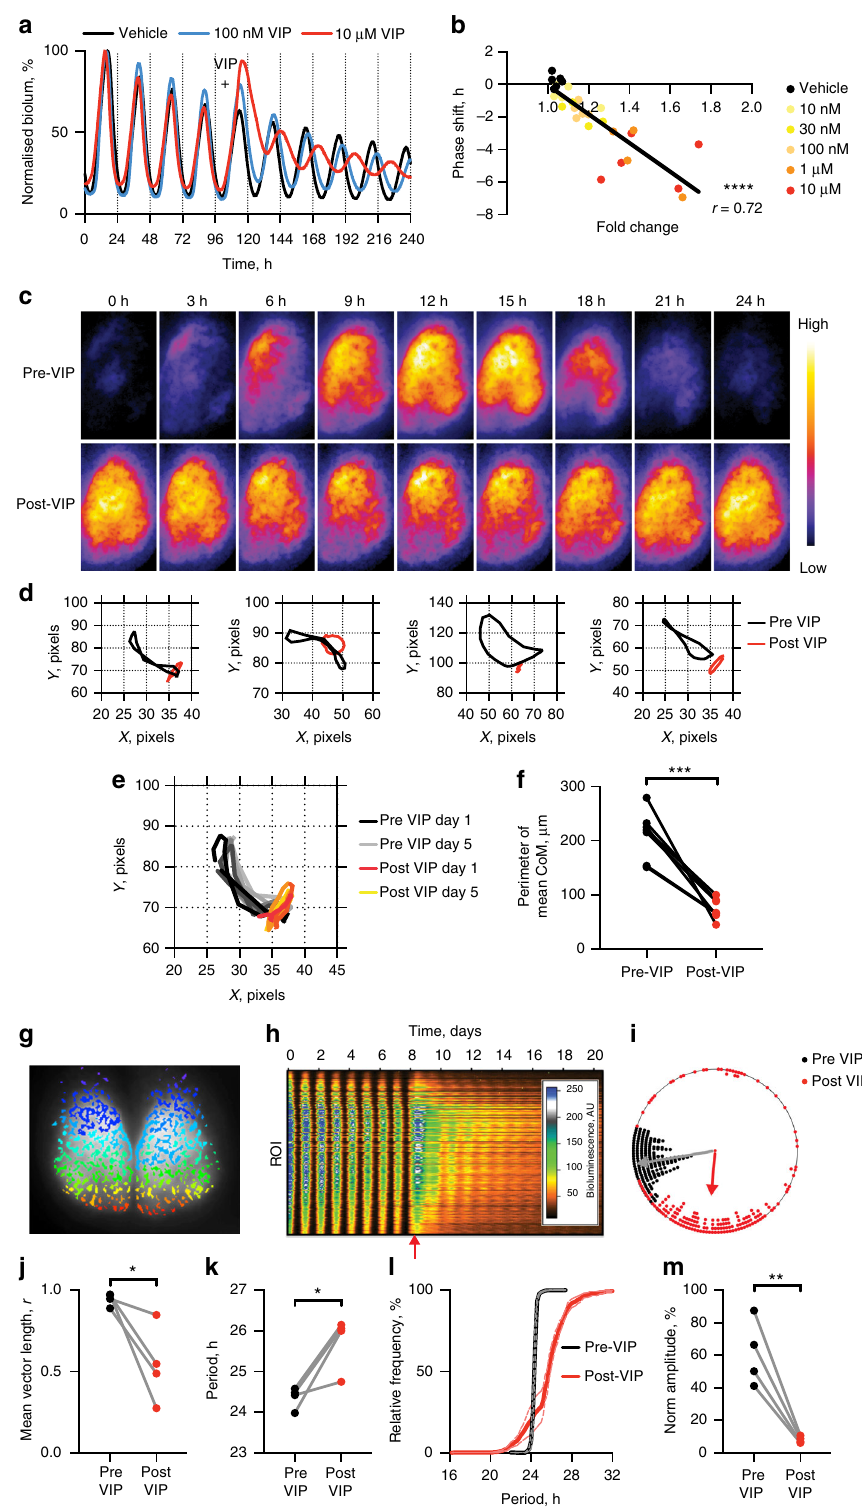
consistently altered from the stereotypical dorsomedial- ventrolateral to a more dorsolateral-ventromedial trajectory after VIP (Fig. 1d, e). This may be in part due to the dorsal tip of the slice displaying a high baseline of bioluminescence but very little oscillation (Fig. 1c). Thus, VIP affects the phase relationships between cellular oscillators within the SCN in a consistent, non- random